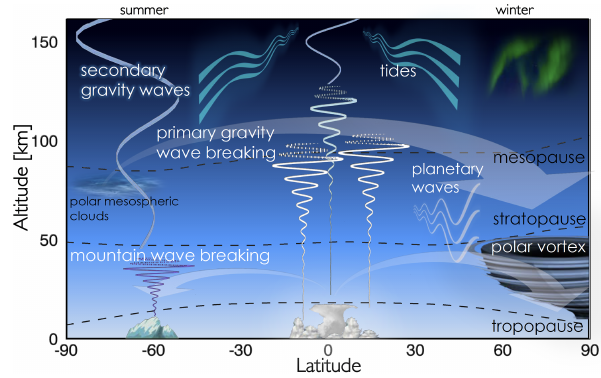
Figure 1. Sources of meteorological variability in the middle atmo- sphere impacting the thermosphere–ionosphere